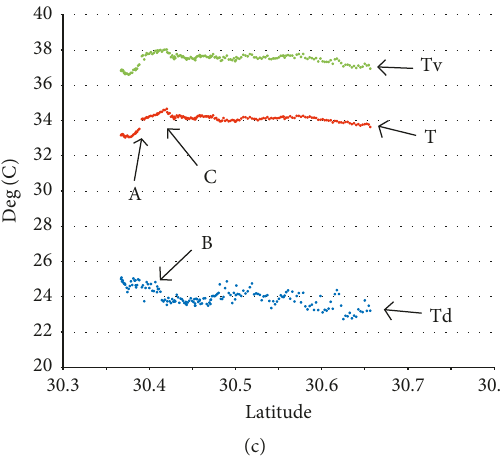
Figure 12: Space series of temperature, virtual temperature, and dewpoint (deg C) from 10 August 2015. Features are labeled as described in text. (a) Southbound Wiggins-Gulfport from 1435 to 1527 UTC (0935–1027 CDT); northbound Gulfport-Saucier from 1617 to 1651 UTC (1117–1151 CDT). (b) Southbound Saucier-Biloxi from 1651 to 1717 UTC (1151–1217 CDT); northbound Biloxi-Saucier from 1805 to 1833 UTC (1305–1333 CDT), (c) Southbound Saucier-Gulfport from 1833 to 1908 UTC (1333–1408